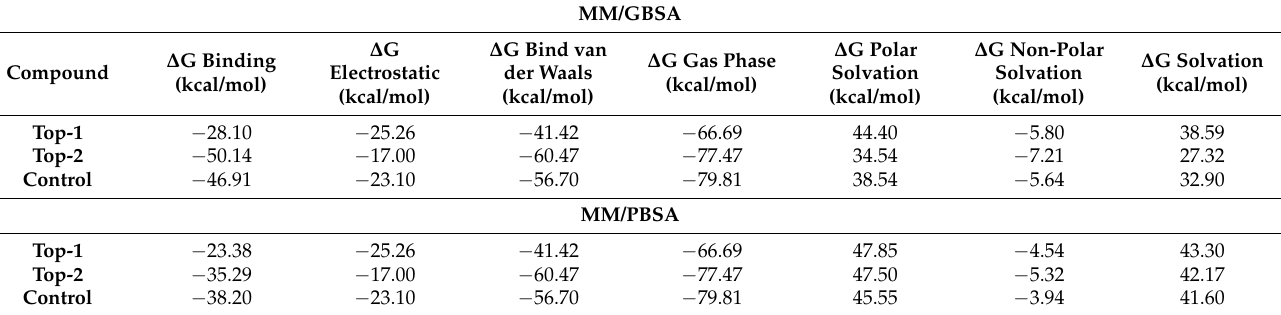
Table 2. MM/GBSA and MM/PBSA binding free energy estimated from 500 frames of molecular dynamics simulation. The net binding free energy value is decomposed further into respective electrostatic, van der Waals, polar, and non-polar solvation energies.